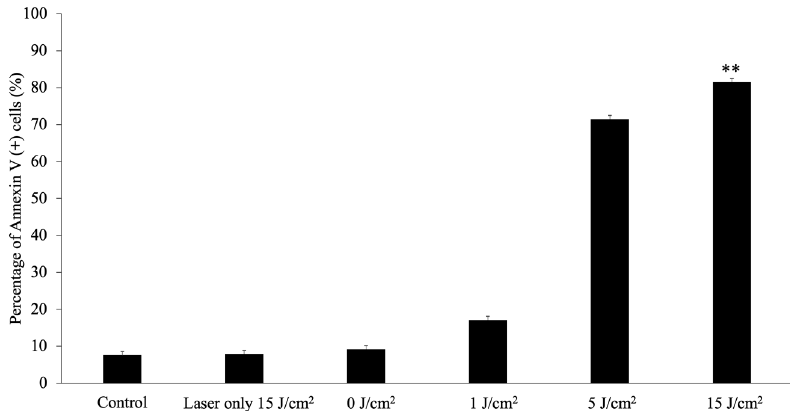
Figure 8. Analysis of apoptosis. Apoptosis was assessed 4 h after laser irradiation using the Muse ® Annexin V and Dead Cell Assay kit. The cells were incubated with 8.0 µ g / mL glucose-conjugated chlorin e6 for 24 h at 37 ◦ C. After washing with fresh media, the cells were irradiated with 650-nm laser light (10 mW / cm 2 ; 0, 1, 5, 15 J / cm 2 ). Data were analyzed using Dunn’s multiple comparison test (* p < 0.05; control vs. 15 J / cm 2 ). The results are presented as the mean ± standard deviation.